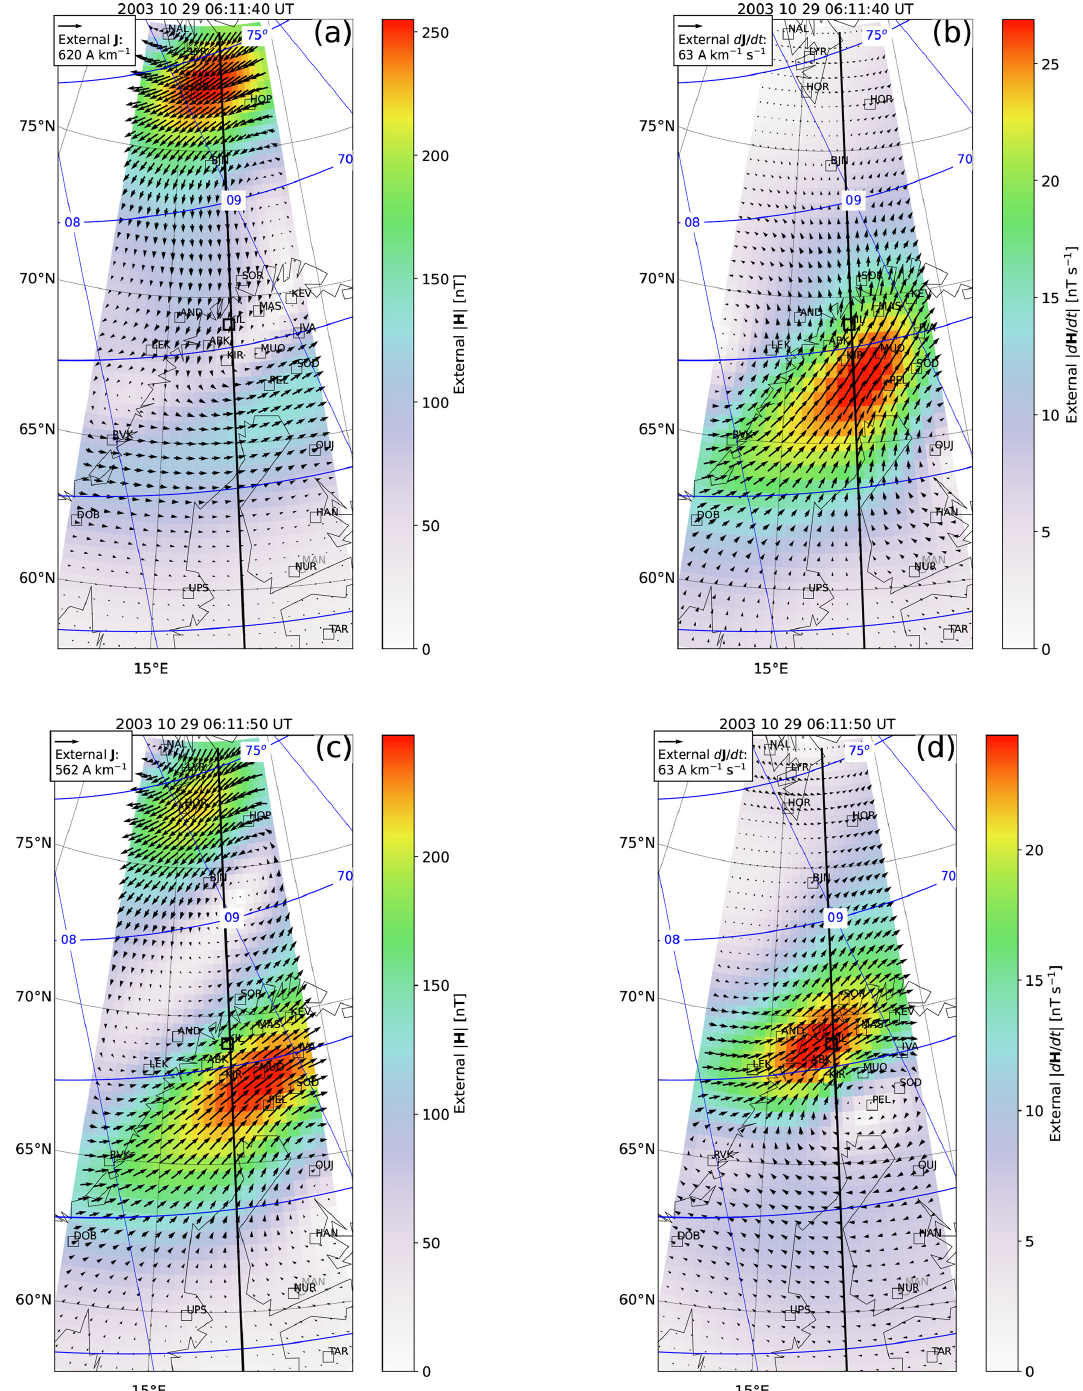
Figure 4. (a) External equivalent current density ( J , arrows) and external horizontal magnetic field on the ground ( | (cid:49) H | , color) on 29 October 2003 at 06:11:40UT when the largest external | d H / d t | between 1994 and 2018 was measured at stations IVA, PEL, RVK, and DOB. (b) 10s time derivative of external J (d J / d t , arrows) and of external (cid:49) H ( | d H / d t | , color). (c–d) The same as (a) – (b) but at 06:10:50UT, when the largest external | d H / d t | was measured at stations KEV, MAS, KIL, ABK, and MUO. In each panel, a vertical black line passing through the KIL station indicates the locations from which latitudes profiles are extracted to create a time series representation of the parameters in Fig.